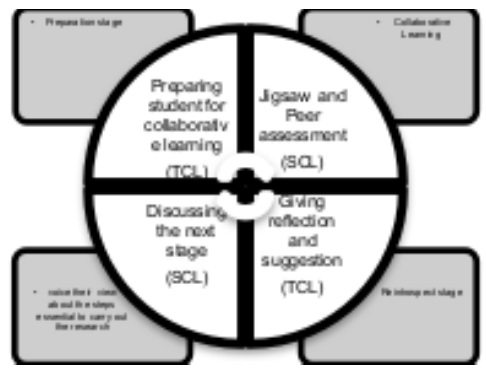
Figure 1. The Cycle of SPoT in Research-Led